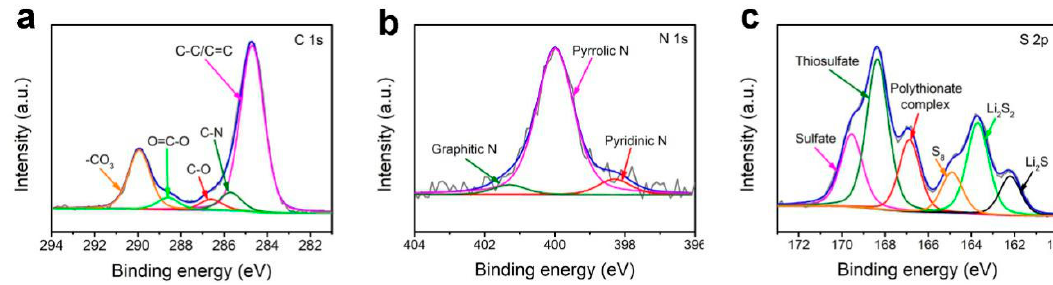
Figure 7. XPS spectra of ( a ) C 1s, ( b ) N 1s and ( c ) S 2p of the PPS coating layer after cycling.